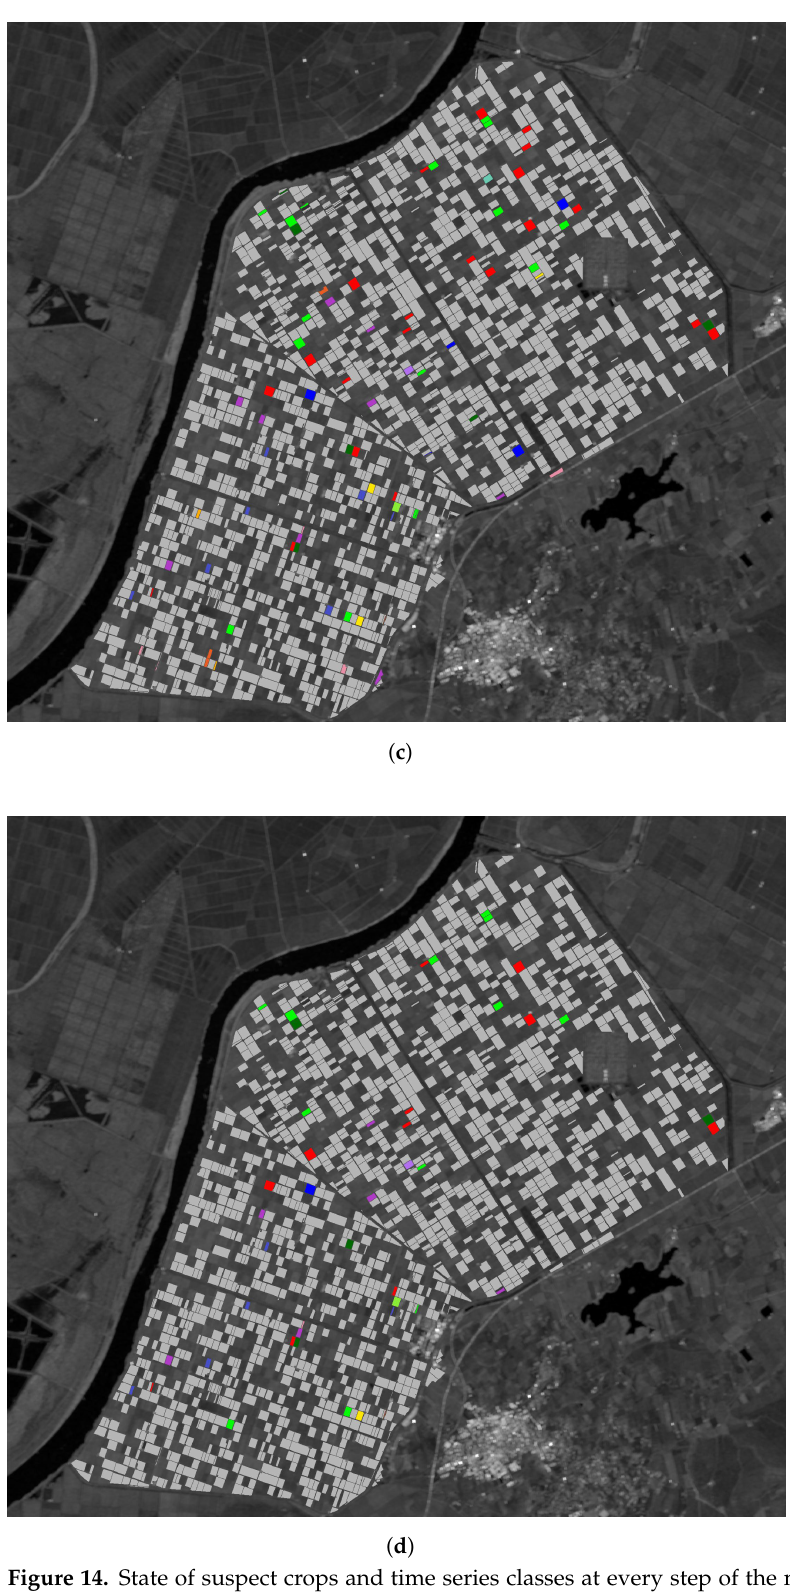
Figure 14. State of suspect crops and time series classes at every step of the method. Classes are displayed only for suspect crops/time series, for ease of visualization. Other crops are shown in gray. ( a ) Class image of suspect crops before relabeling. ( b ) Candidate class image of every suspicious time series (trustworthy time series in gray). ( c ) Candidate class image of every suspicious crops (no Otsu Thresholding applied). ( d ) Class image after relabeling (Otsu Thresholding